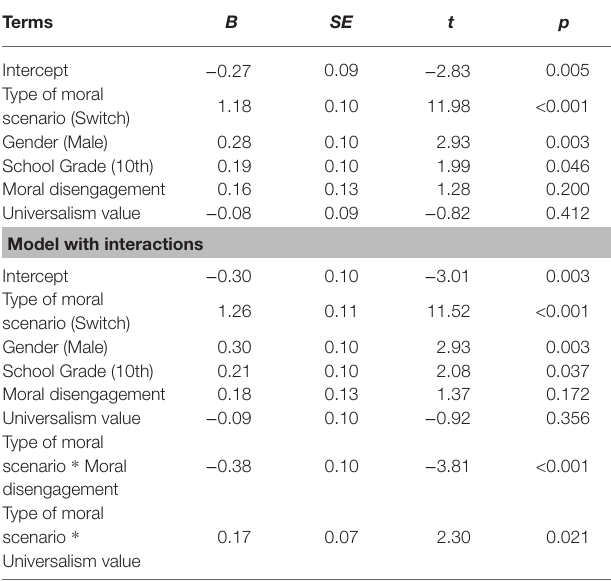
TABLE 3 | Generalized linear mixed model (3) – Moral-related variables predicting No/Yes answers in moral dilemmas.